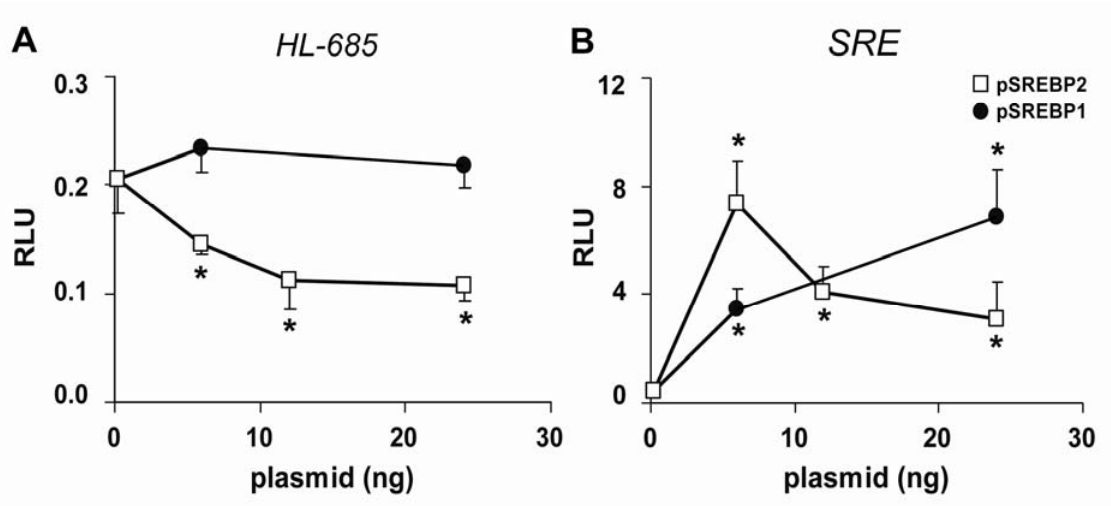
Figure 2. Effect of nSREBP2 and nSREBP1 on HL-685 promoter activity. HepG2 cells were transfected with the plasmidsHL − 685 (A) or SRE-luc (B), and the indicated amounts of pSREBP1 or pSREBP2 (open and closed symbols, respectively). Relative luciferase activity (RLU) was determined after 48h (n = 3; *: P < 0.05 compared to